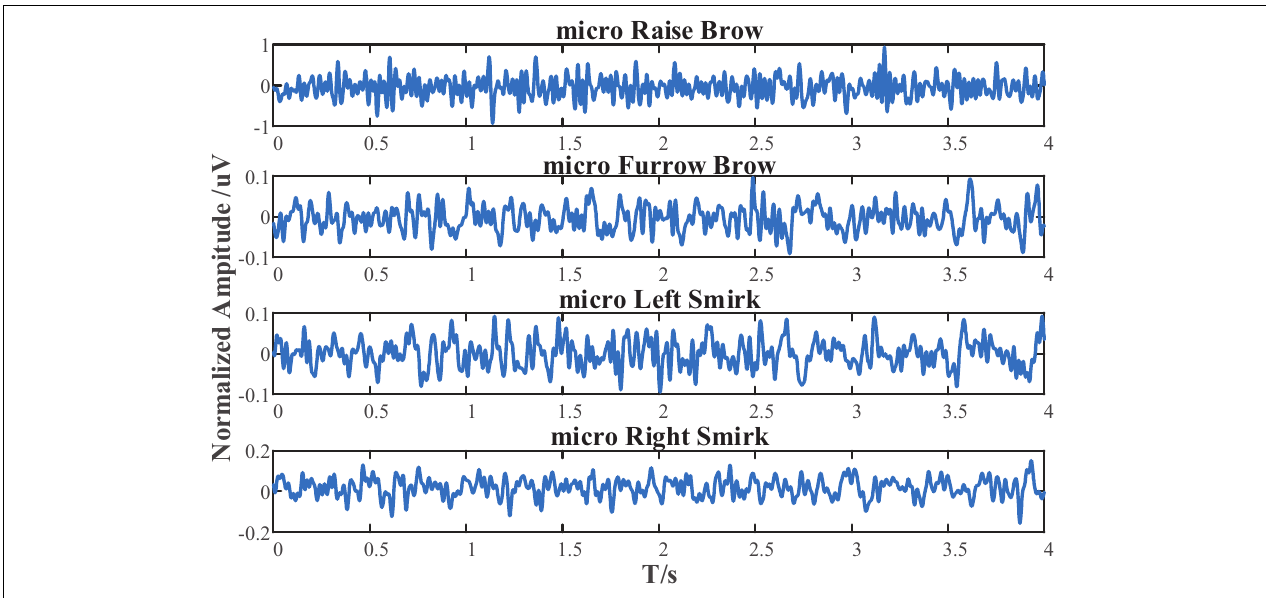
FIGURE 15 | Simulated postsynaptic membrane potentials of subject S1 under micro-raise-brow, micro-furrow-brow, micro-left-smirk, and micro-right-smirk.